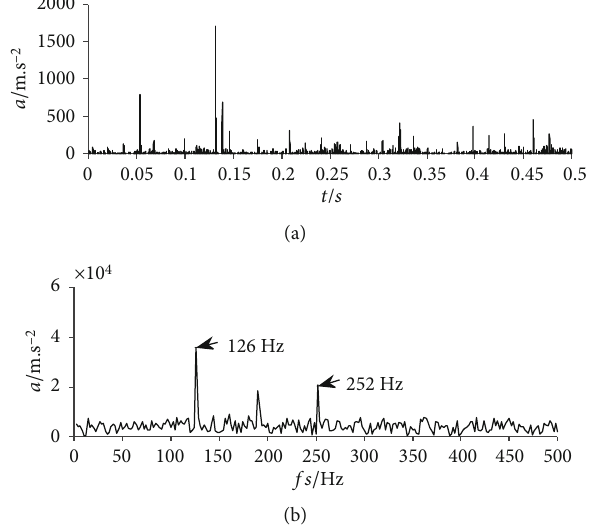
Figure 9: Waveform and frequency spectrum of bearing R outer ring defect signal denoised by a traditional morphological fi lter with small-scale structuring elements. (a) Waveform. (b) Frequency spectrum.